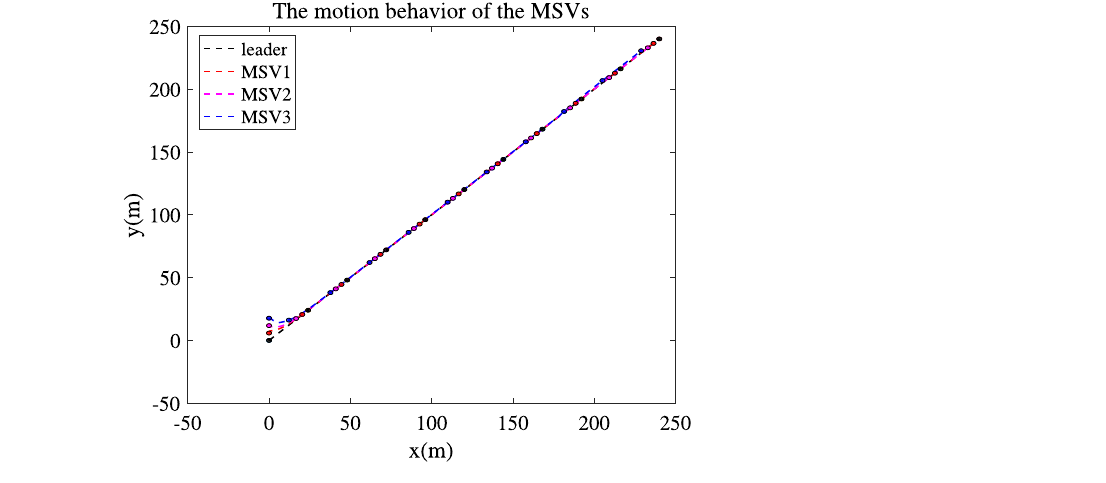
Figure 3. Platoon formation process of the 4